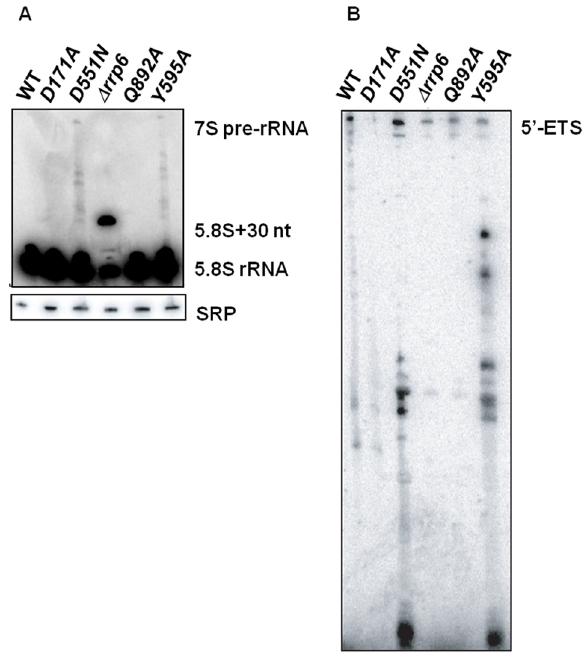
Figure 5. Y595 residue is required for both RNA-processing and degradation. The indicated Rrp44 proteins were expressed in a rrp44 D yeast strain. RNA was isolated from cultures grown in rich medium and analyzed by northern blotting with probes that hybridize to the 5 9 ETS region (panel A), 5.8S rRNA (panel B) and the RNA subunit of the signal recognition particle